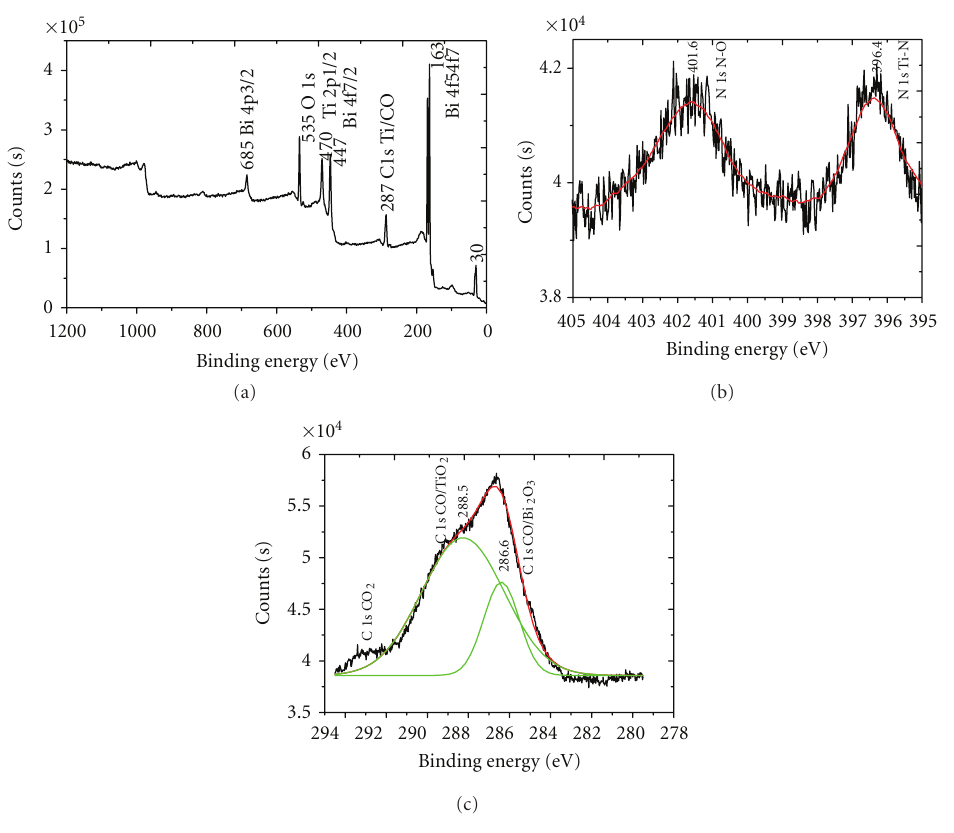
Figure 3: XPS absorption spectra of bismuth titanate Bi 12 TiO 20 − y N y ( y = 0 . 03): (a) the whole spectrum of Bi 12 TiO 20 − y N y ( y = 0 . 03); (b) spectrum of doped nitrogen; (c) spectrum of doped carbon.